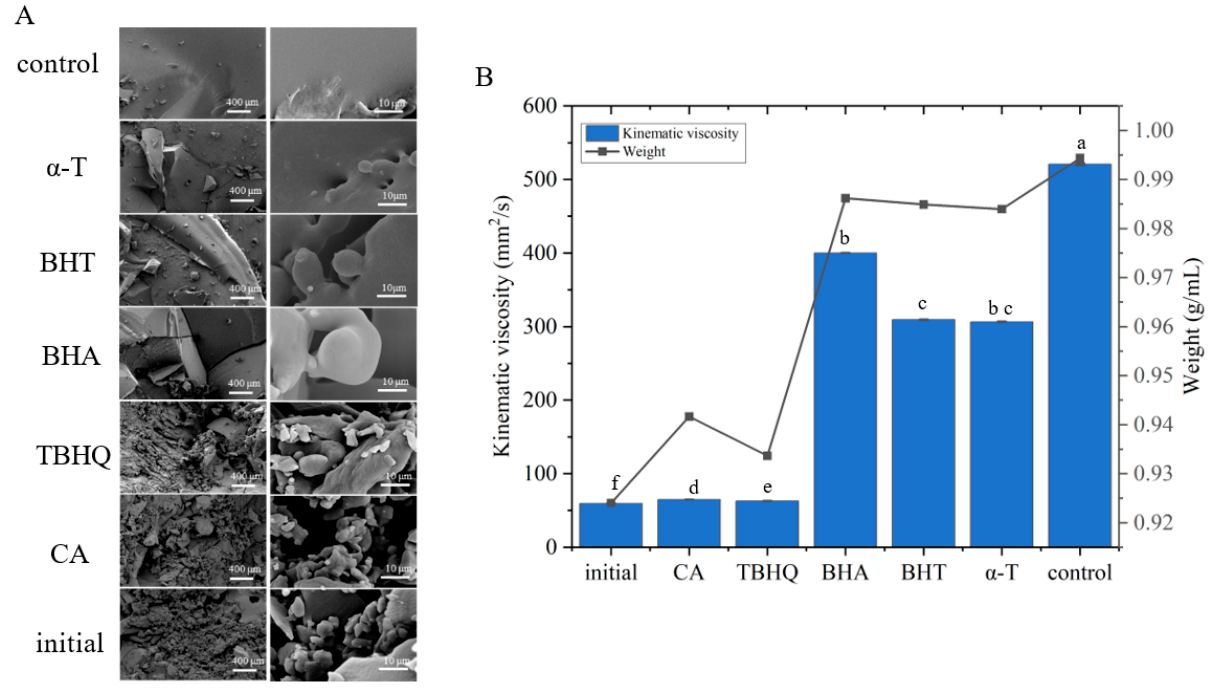
Figure 4. The physical characteristic of the Aoil enriched with different antioxidants. ( A ), Microstruc- ture of Aoil at the beginning and storage at 60 ◦ C for 30 d. ( B ), Weight and kinematic viscosity of Aoil at the beginning and storage at 60 ◦ C for 30 d. a–f means with different superscripts differ signi fi cantly ( p < 0.05).